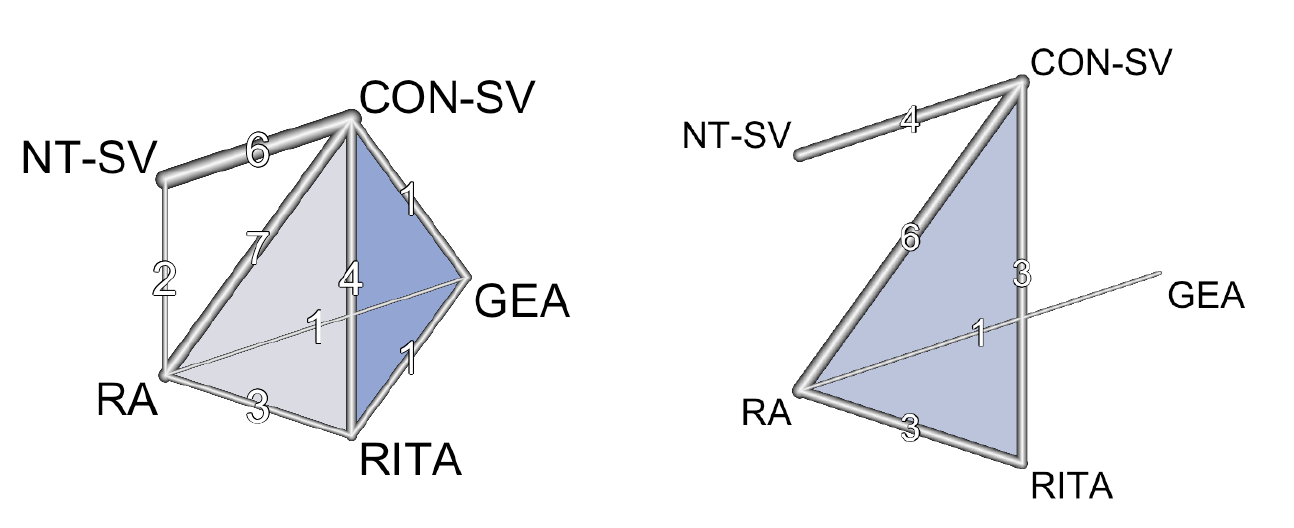
Fig. 2 - Net graph of the different comparisons for A) the primary outcome of graft occlusion and B) the secondary outcome of late mortality. Width of the lines indicate the number of studies comparing each pair of treatment. In the network plots, colored polygons indicate the presence of multi-arm (3 or more) trials, whereas line shading and thickness are inversely proportional to standard errors of the fixed effect estimate stemming from direct between-arm comparisons. CON-SV=conventionally harvested saphenous vein; GEA=gastroepiploic artery; NT-SV=no-touch saphenous vein; RA=radial artery; RITA=right internal thoracic artery.